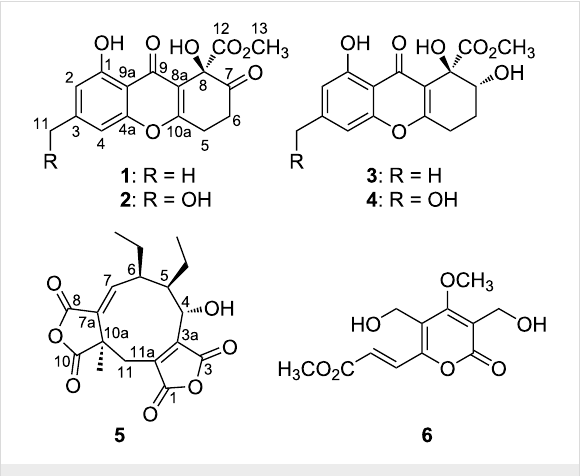
Figure 1: Structures of compounds 1 – 6